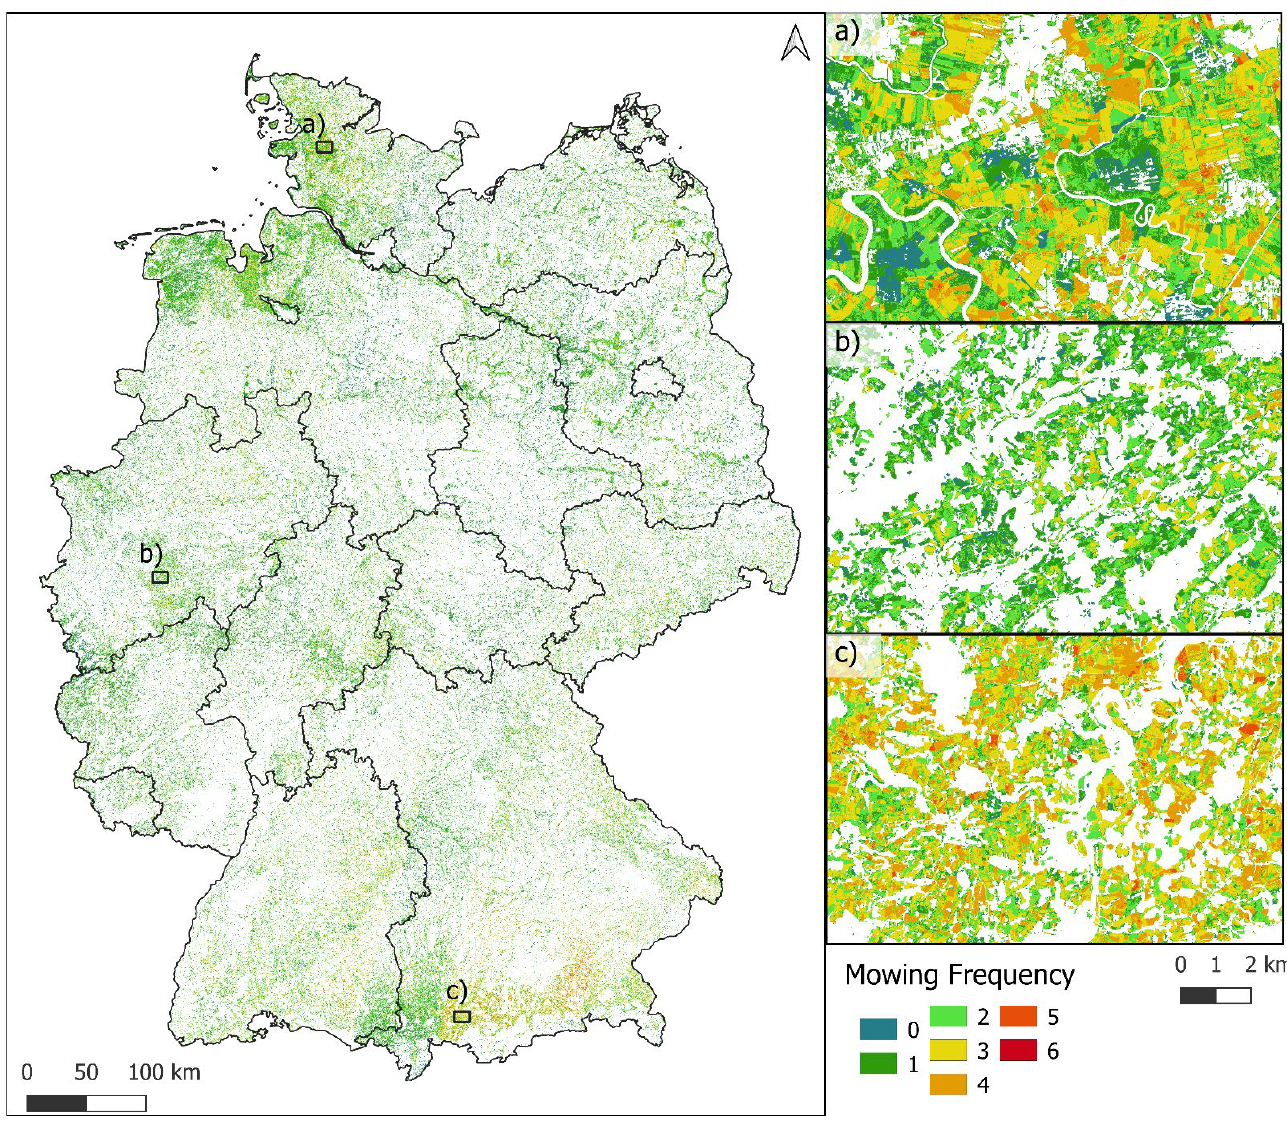
Figure 10. Mowing frequency 2019 on grassland with a spatial resolution of 10 m based on EVI time series data for Germany and for three zoom regions (a, b, c) indicated on the map.